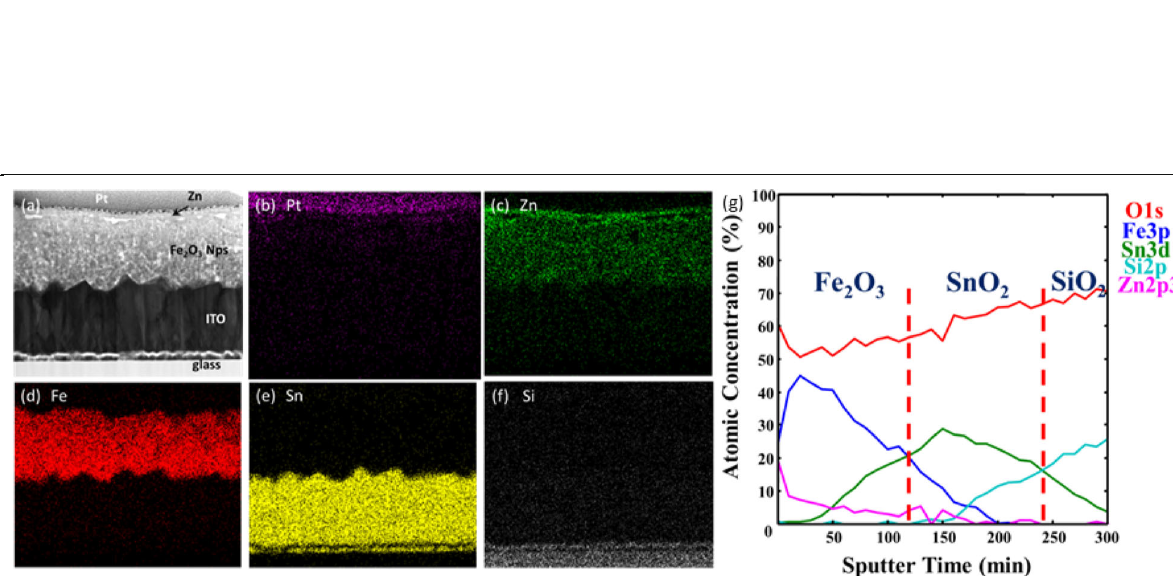
Fig. 4 Cross-sectional imaging and chemical mapping of Zn/Sn-doped p-n pseudocubic Fe 2 O 3 photoelectrode: a – f STEM images of the cross- section of an Zn/Sn-doped PN pseudocubic Fe 2 O 3 photoelectrode. Note that the thin Pt layer seen in the image was deposited over the sample as a protection layer for the focused ion beam (FIB) milling step for cross-sectional sample preparation. g EDS mapping showing Zn, Fe, Sn, and Si elemental distributions respectively for the same sample as in